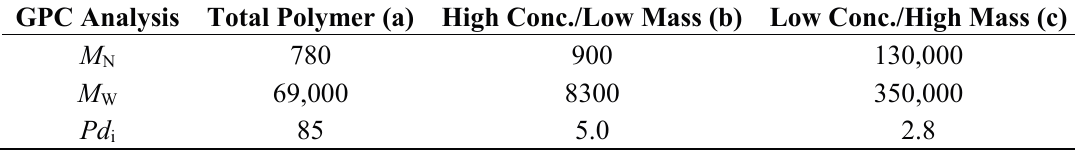
Table 2. GPC data for